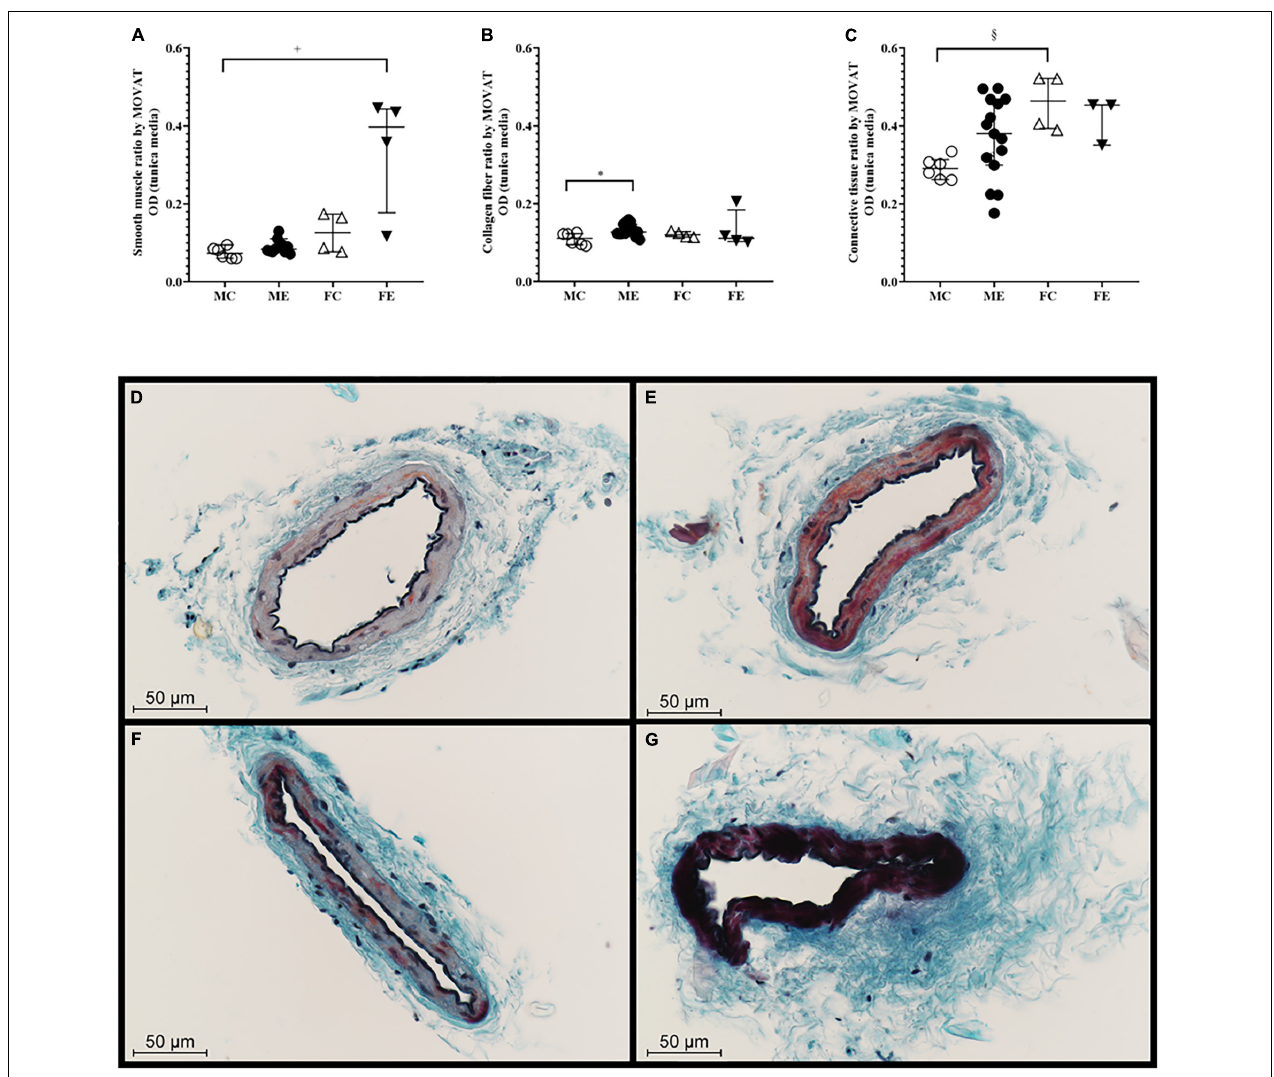
FIGURE 8 | MOVAT staining. (A) Smooth muscle staining intensity of segments from the MC, ME, FC, and FE animals. Smooth muscle density was significantly higher in the FE rats than in the MC rats. (B) Collagen staining intensity of the segments from the MC, ME, FC, and FE animals. The density of the collagen was significantly higher in the male exercised group compared with the male control rats. (C) Connective tissue staining of the segments from the MC, ME, FC, and FE animals. (D) Representative staining in the MC rats. (E) Representative staining in the ME rats. (F) Representative staining in the FC rats. (G) Representative staining in the FE rats. The density of connective tissue was significantly higher in the female control group than in the male control group. The data are expressed as the median (interquartile ranges) values. The significance levels of Kruskal–Wallis test and Dunn’s post hoc tests between the four groups are shown. + P < 0.05 MC vs. FE; * P < 0.05 MC vs. ME and § P < 0.05 MC vs.